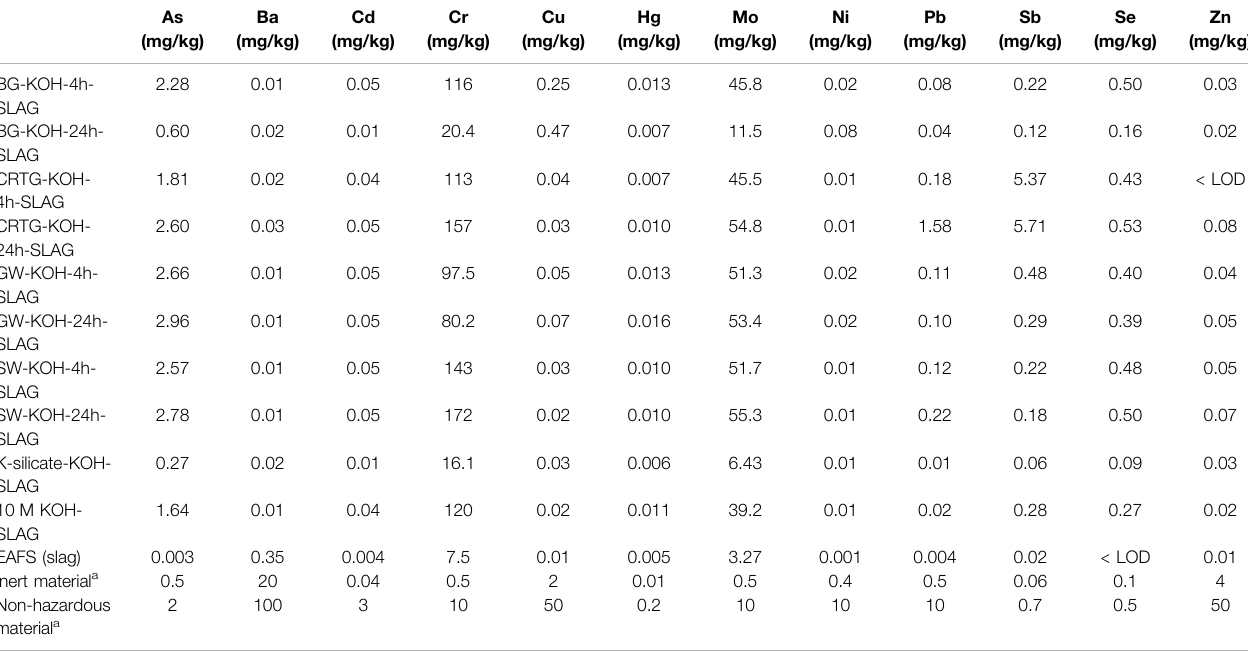
TABLE 6 | The concentrations of 12 elements measured in leachates in leaching experiments performed following the SIST EN:12457-2 standard protocol. As